Question: Identify the chart type used in this figure.
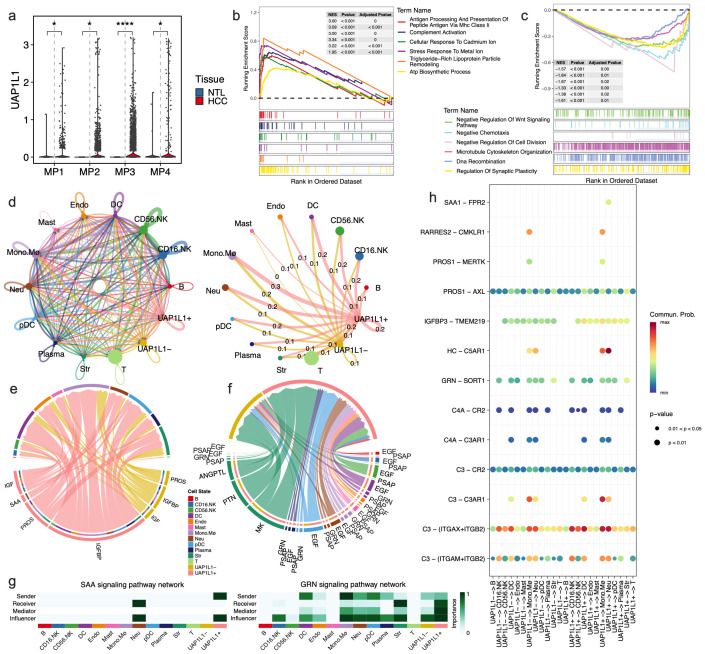
Answer: heatmap